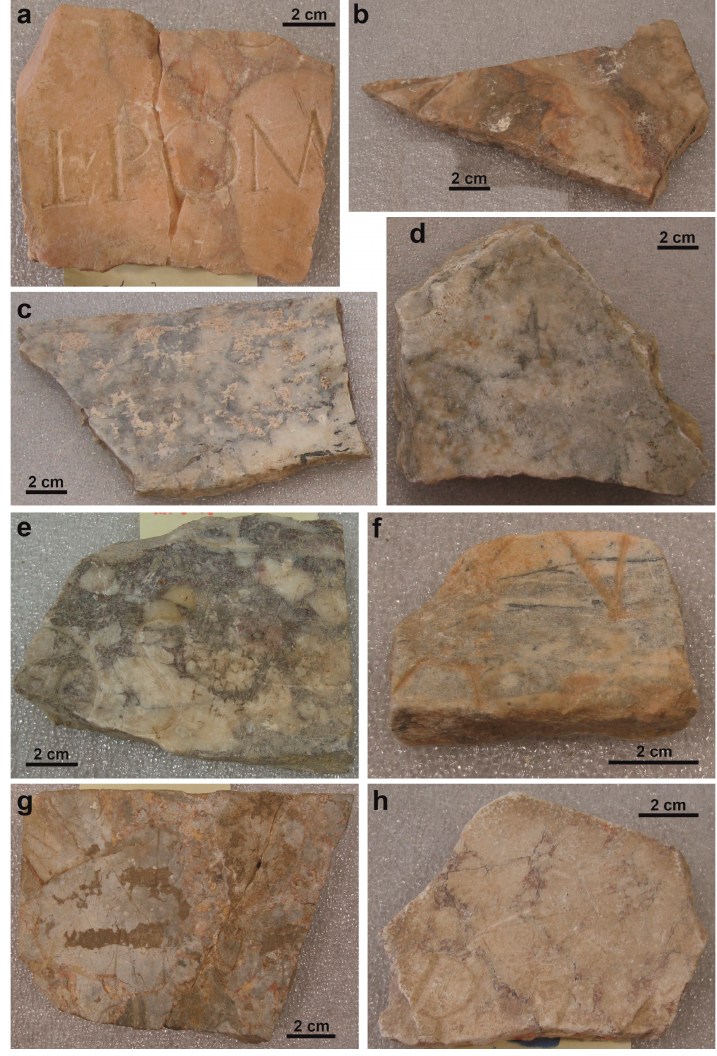
Figure 4. Photos of the fragments of polychrome marbles used as support for the inscriptions: ( a ) giallo antico ; ( b ) alabastro fiorito ; ( c , d , f ) greco scritto ; ( e ) pavonazzetto ; ( g ) breccia di Aleppo ; ( h ) breccia corallina .